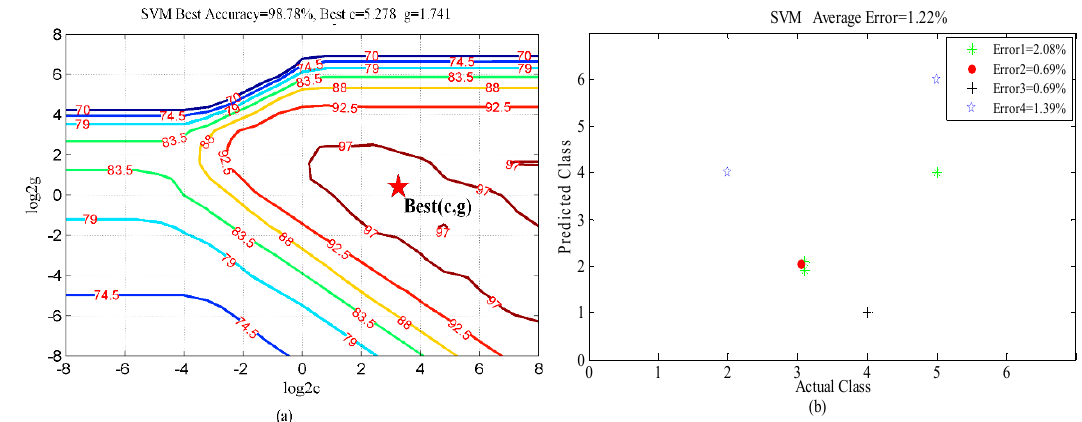
Figure 10. Classification results from four-fold cross-validation for the first scenario. ( a ) Parameter selection results; ( b ) Classification errors distribution of the four-fold cross-validation (the horizontal axis represents the actual activity class represented as the numbers 1 – 6, the vertical axis represents the predicted activity class represented as the numbers 1 – 6).